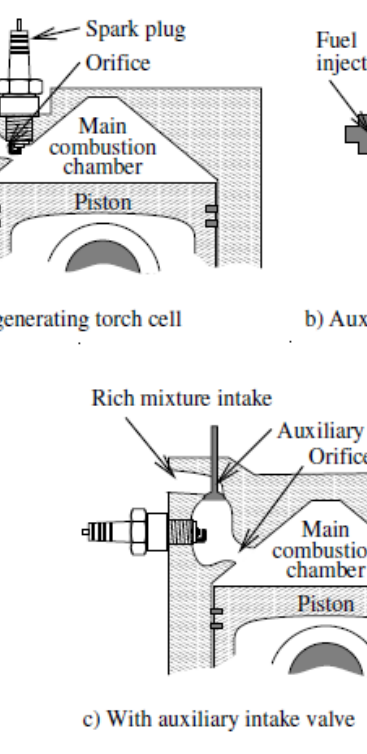
Figure 1. Classification of the prechamber: ( a ) unfueled prechamber; ( b ) fueled prechamber with direct-injected; ( c ) indirectly injected fueled prechamber [22,26] .